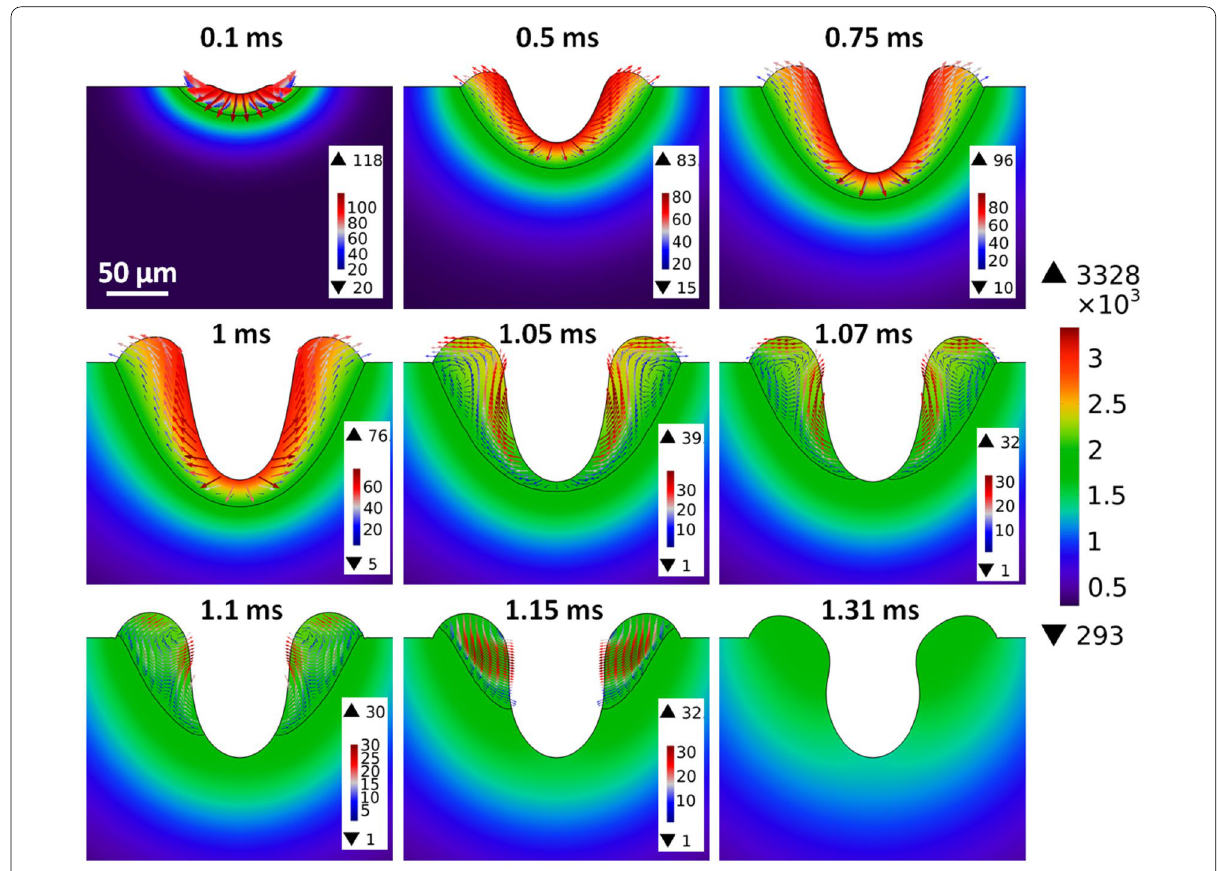
Figure 28 Evolution of melt pool shape for first pulse, temperature field and velocity field